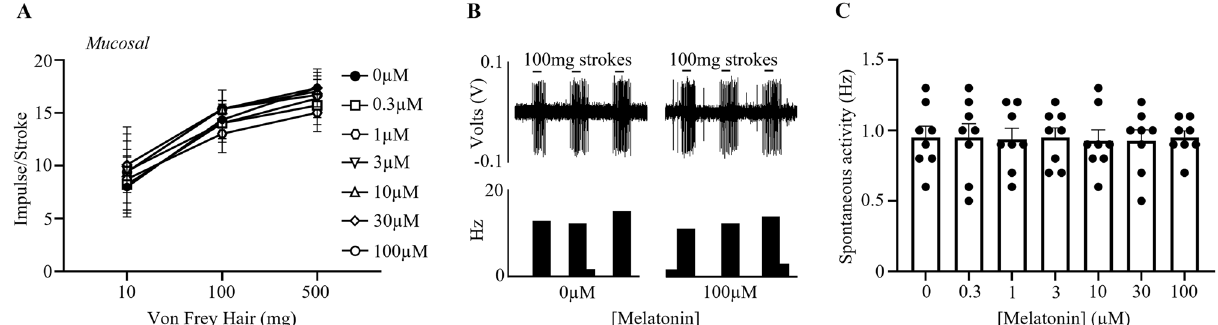
Figure 1. Melatonin does not affect the mechanosensitivity of mucosal bladder afferents. ( A ) The responses of bladder mucosal afferents to von Frey hair stroking (10, 100, and 500 mg) in the absence and presence of melatonin (0.3–100 μM). ( B ) A raw trace example of bladder mucosal afferent responses to stroking (100 mg) in the absence or presence of melatonin (100 μM). ( C ) The spontaneous activity of mucosal afferents in the absence and presence of melatonin (0.3–100 µM). Data is presented as the mean ± the SEM, N = 8, n = brain GABAergic neurons 21 . Ex vivo studies demonstrated that melatonin suppressed detrusor contractions induced by electrical stimulation, high K + , and L-type Ca 2+ channel agonist. This inhibition of contractions, however, was not blocked by MT1/MT2 receptor antagonism 22 .